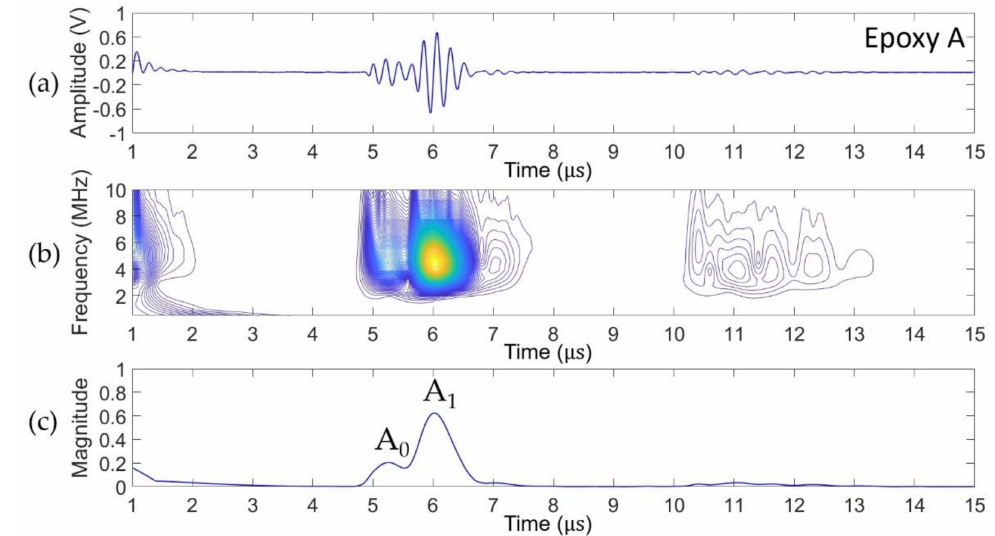
Figure 9. Experimental result of the debonded epoxy A coating layer: ( a ) time-domain signal, ( b ) spectrogram, and ( c ) the STFT magnitude